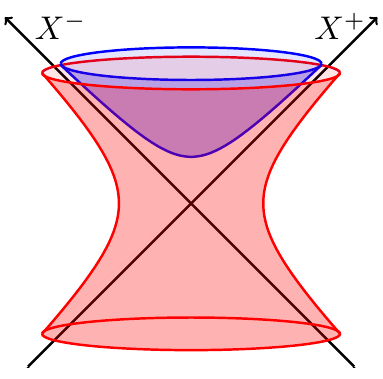
Figure 1 . EAdS 2 (blue) and dS 2 (red) realised as Lorentz-invariant subset of R 1 , 2 , here represented with Lightcone axes X ± = X 0 ± X 2